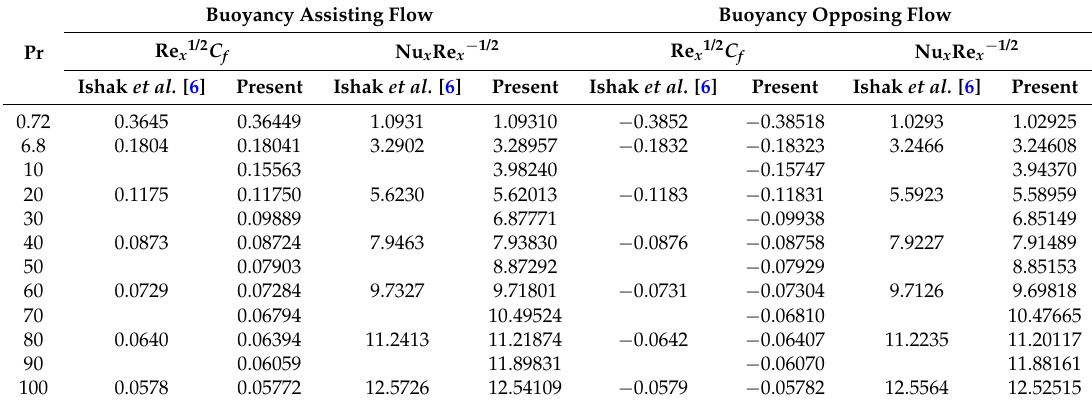
Table 1. Comparison of the values of Re 1 { 2 x C f and Nu x Re ´ 1 { 2 x